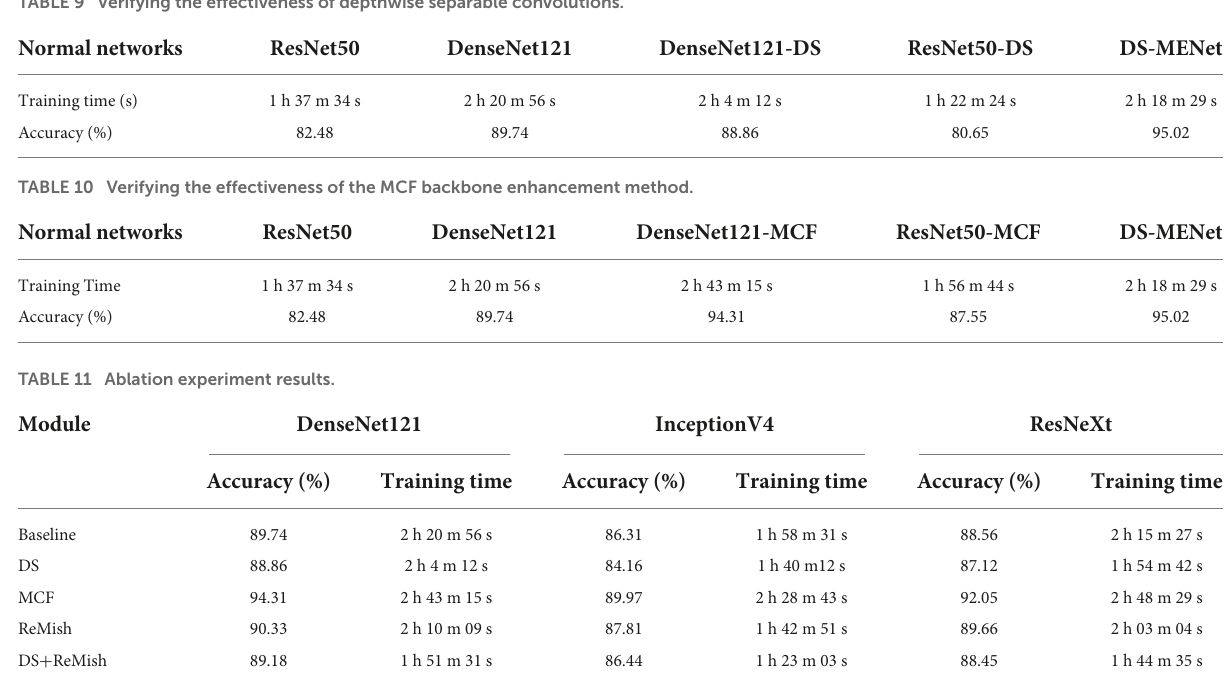
TABLE 9 Verifying the effectiveness of depthwise separable convolutions.